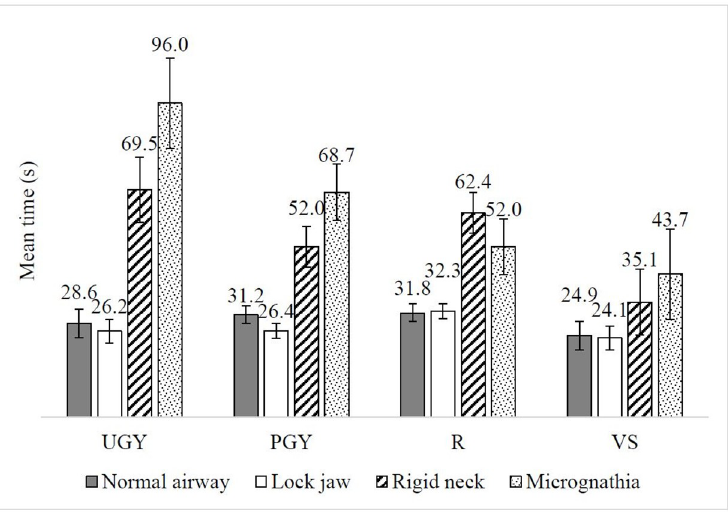
Fig 3. Mean time to intubation(s) across UGY, PGY, R and VS in different intubation scenarios. Error bars represent ± 1 SE.